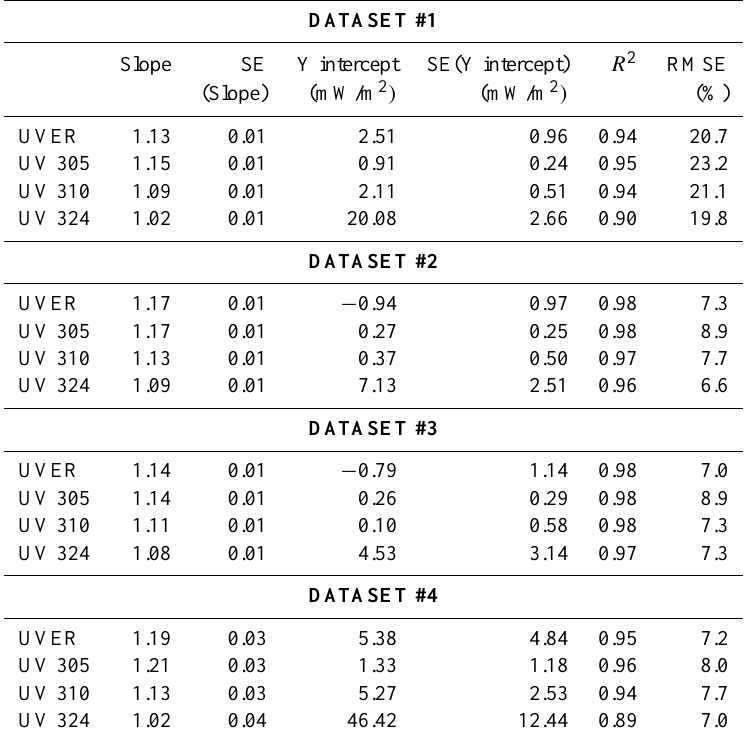
Table 1. Results of linear regression analysis between OMI and Brewer UV products for all sky conditions (dataset #1), cloud-free conditions (dataset #2), cloud-free cases with low aerosol load (dataset #3), and cloud-free cases with moderate-high aerosol load (dataset #4). The parameters are the following: the slope of the regression, the standard error (SE) of the slope, the Y intercept, the SE of the Y intercept, the correlation coefficients ( R 2 ) , and the root mean square errors (RMSE).